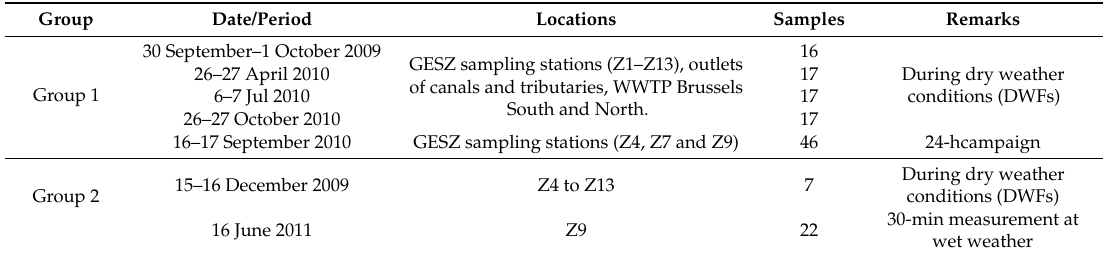
Table 3. The Good Ecological Status of the river Zenne (GESZ) sampling campaigns.